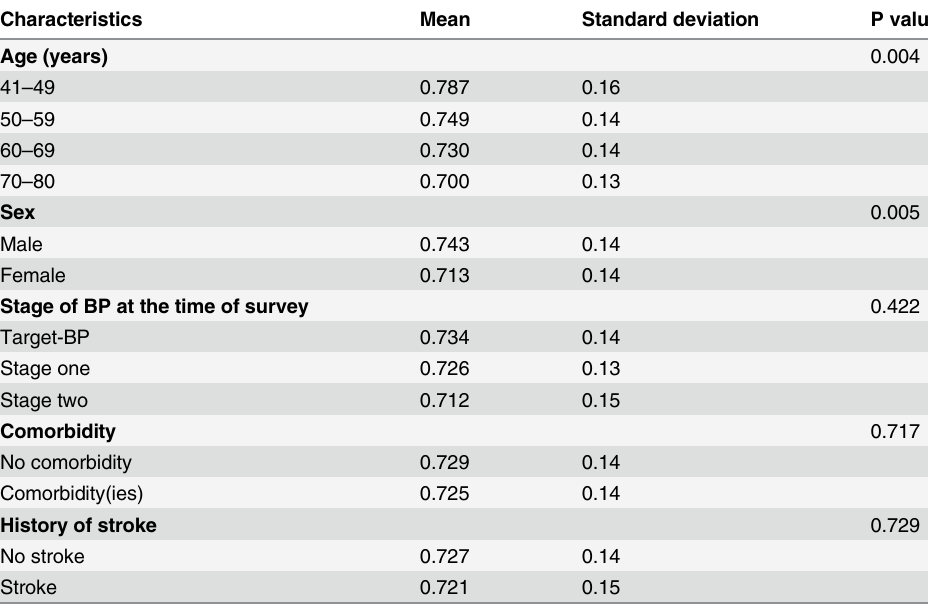
Table 2. Distribution of health-state utilities by patients ’ characteristic (n =